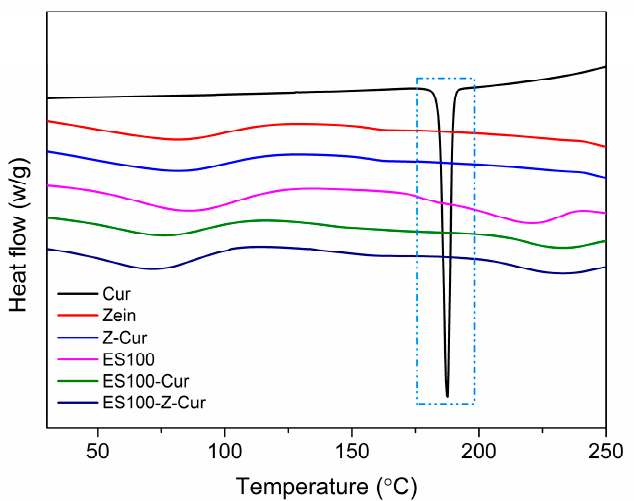
Figure 5. DSC thermograms of pure Cur, zein, released self-assembled Z–Cur, ES100, ES100–Cur, and ES100–Z–Cur.